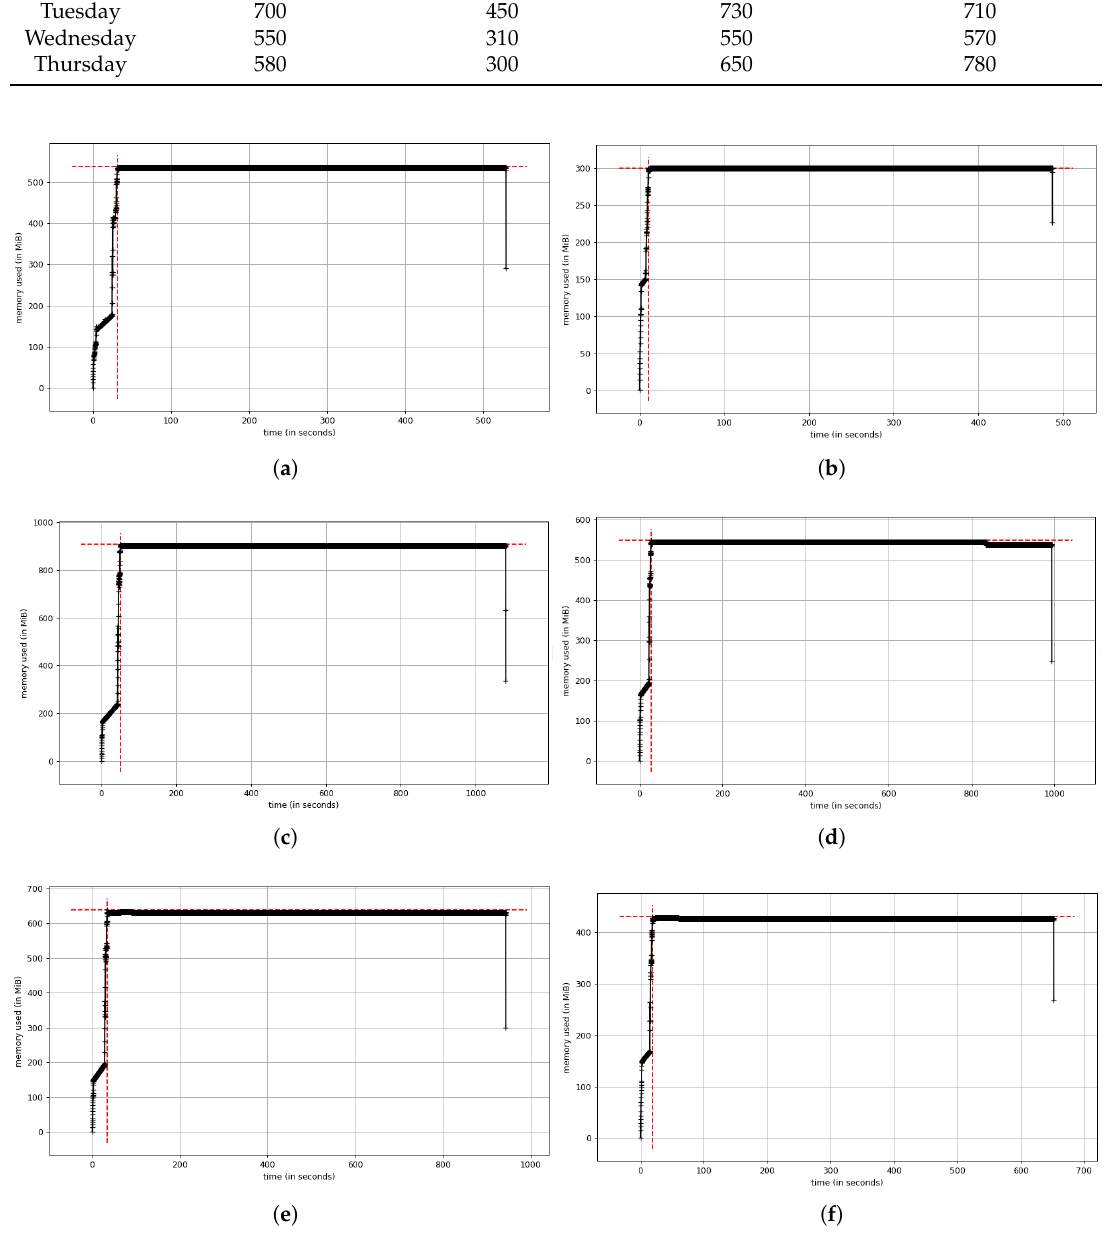
Figure 17. Memory profile results of LSTM model on complete feature data and selected feature subset data respectively. ( a ) & ( b ) Saturday data; ( c ) & ( d ) Sunday data; ( e ) & ( f ) Monday